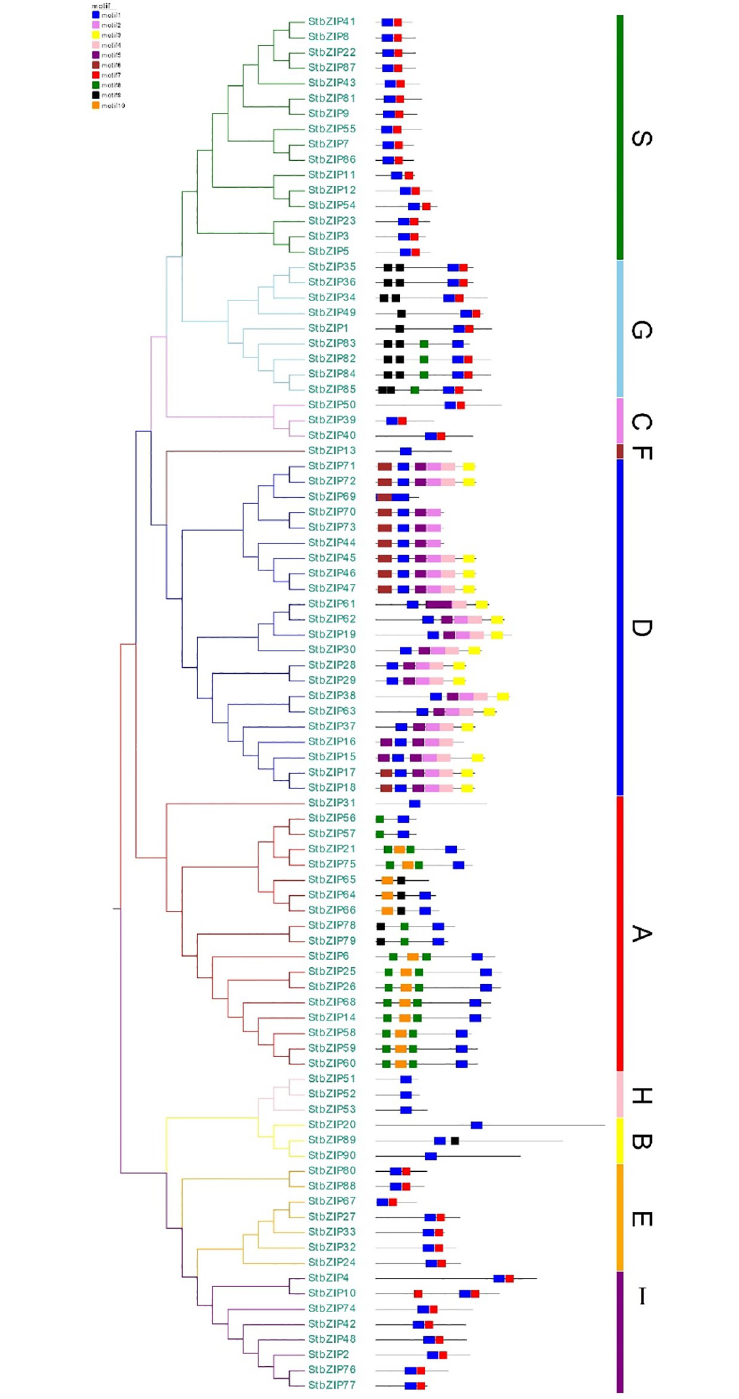
Fig 2. Motif and cluster analysis of StbZIPs. The conserved motifs of StbZIPs were identified using the MEME database. Based on the clustering relationship, the StbZIPs were classified into ten groups shown as A to I, and S.